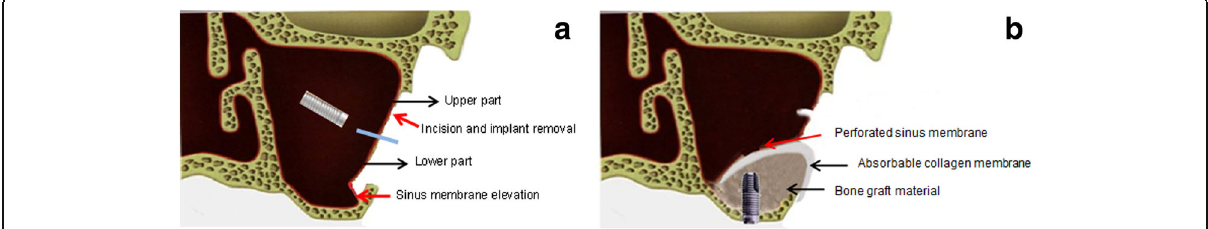
Fig. 2 Illustration describing the bony window extended upward. a The upper part is used for removal of displaced implant and the lower part is used for elevation of sinus membrane. b The perforated sinus membrane was covered with absorbable collagen membrane and implants placed with sinus bone